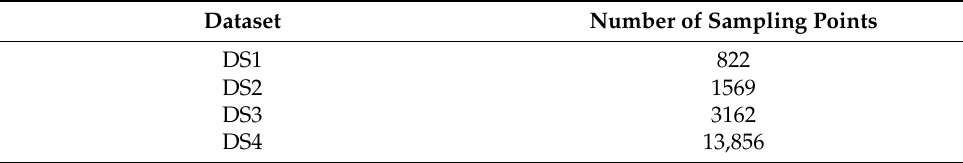
Table 2. Number of sampling points in the dataset.